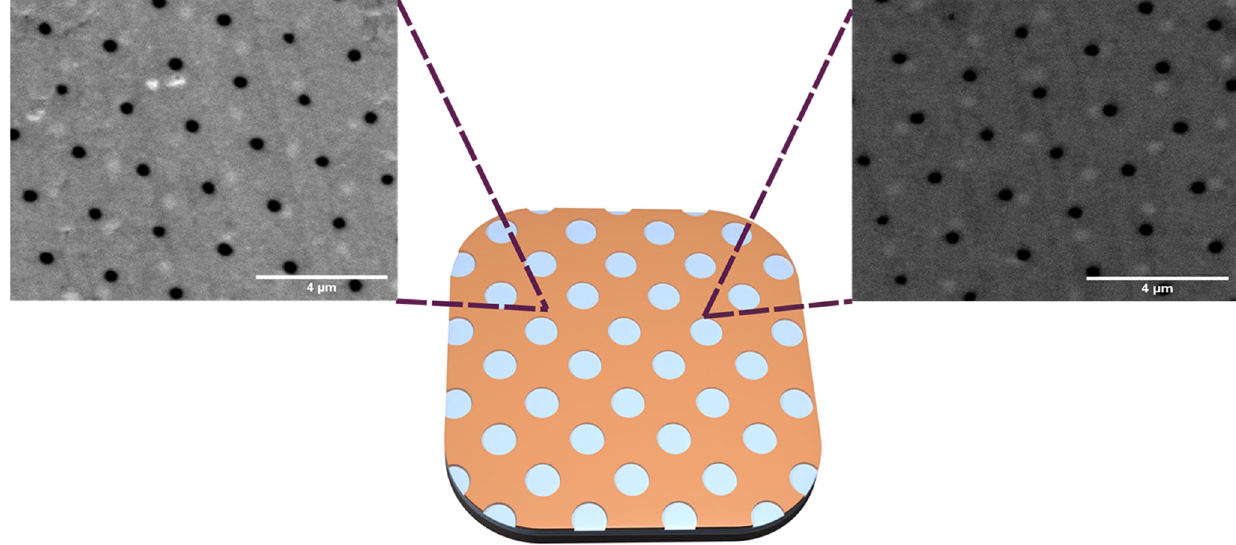
Fig. 3 Flexible substrates characterization after NIL process. Top view SEM images after the resist removal, at opposite sides of fl exible substrate, with the identi fi cation on the location of the SEM images. The point contact shape and dimension are retained regardless of the distance between the measurement, which indicates high quality for the demoulding